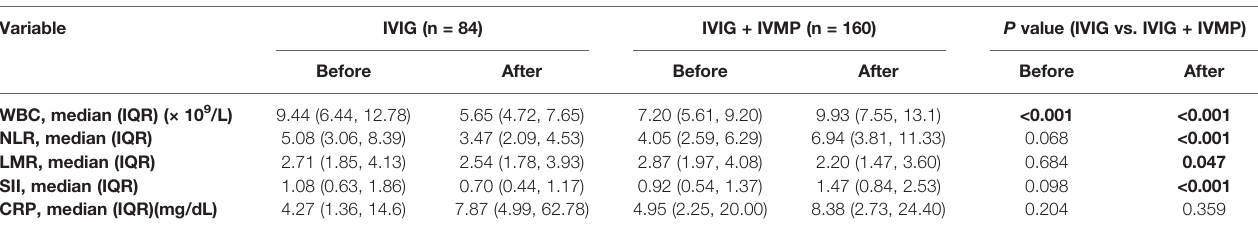
TABLE 3 | Comparisons of laboratory parameters before and after immunotherapy. Variable IVIG (n = 84) Before After Before After Before After WBC, median (IQR) (× 10 9 /L)